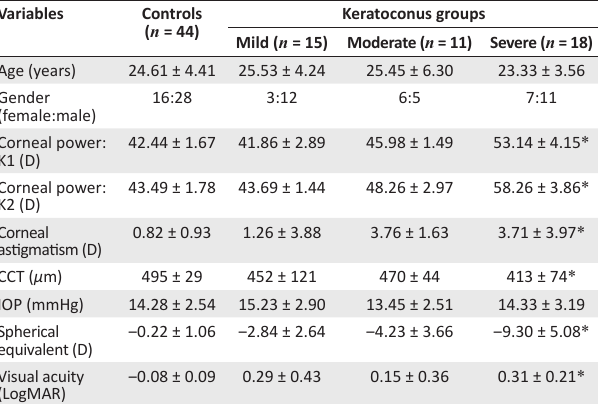
TABLE 1: Means and standard deviations for demographic and ocular characteristics in the four study groups. Variables Controls ( n =